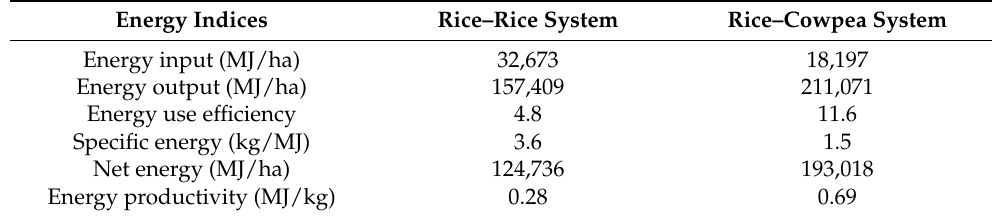
Table 3. Energy indices as influenced by rice-based cropping systems in the coastal region of Goa. Energy